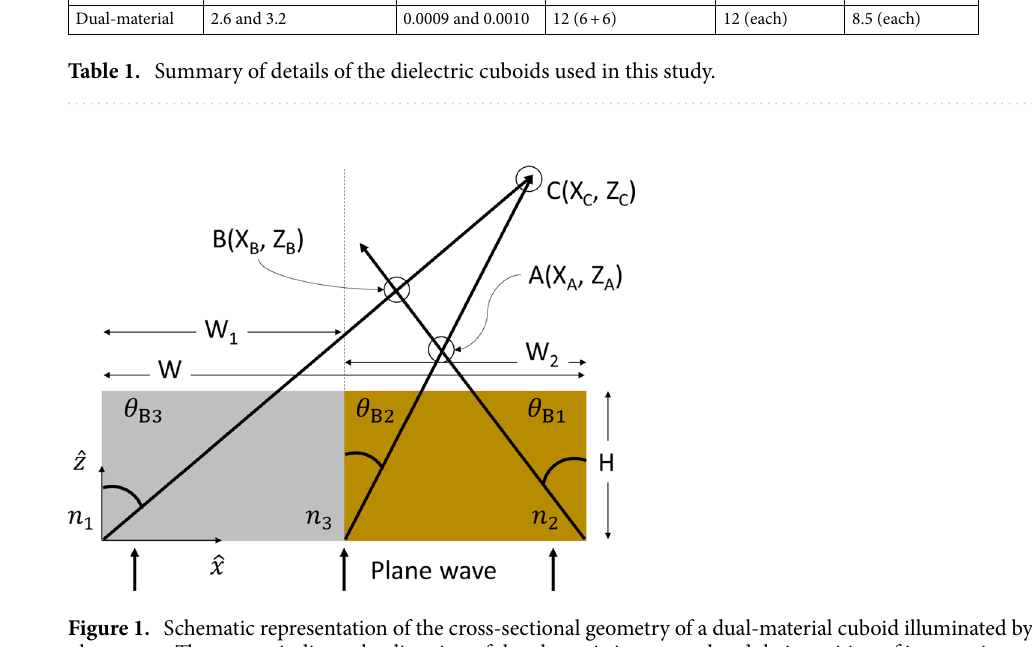
Figure 1. Schematic representation of the cross-sectional geometry of a dual-material cuboid illuminated by a plane wave. The arrows indicate the direction of the photonic jets created and their position of